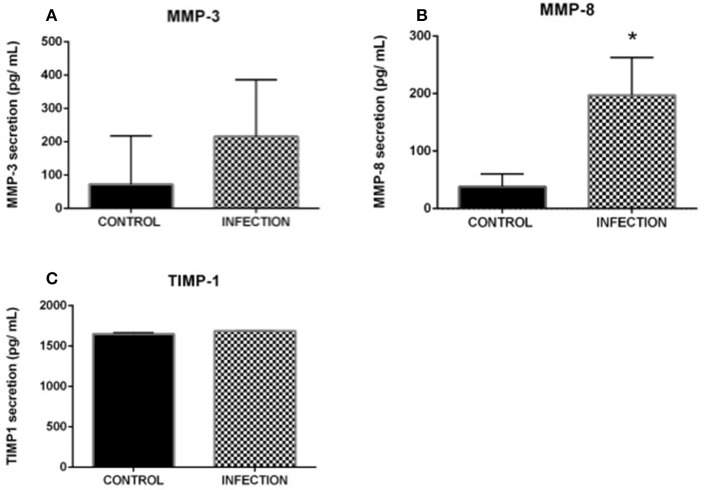
Evaluation of MMP-3 (A), MMP-8 (B), and TIMP-1 (C) protein expression upon gonococcal infection. Supernatant from control and infected explants was evaluated with sandwich immunoassays to evaluate the secretion of MMP-3, MMP-8 and TIMP-1. A significant increase in MMP-8 secretion was observed from infected explants compared with that in the control (p < 0.05); the other evaluated proteins showed no significant variation. Each sample was assayed in duplicate, and four different patient samples were used. Each bar represents the mean ± SEM. *Indicates a significant change.